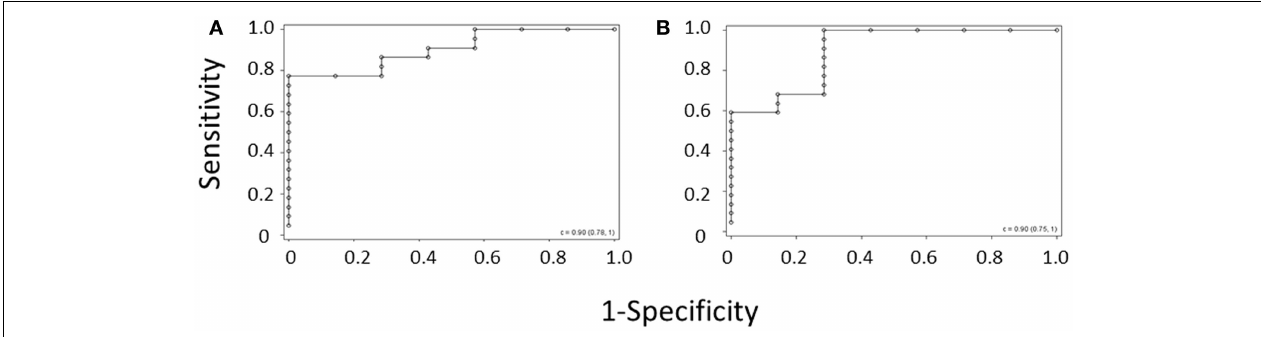
FIGURE 3 | ROC curve derived from (A) the MPV rule or (B) the IPF/PLT rule in the validation cohort . Each open circle marks the sensitivity and specificity of a given MPV cutoff. C-statistics appear in the lower right-hand corners of the graphs.